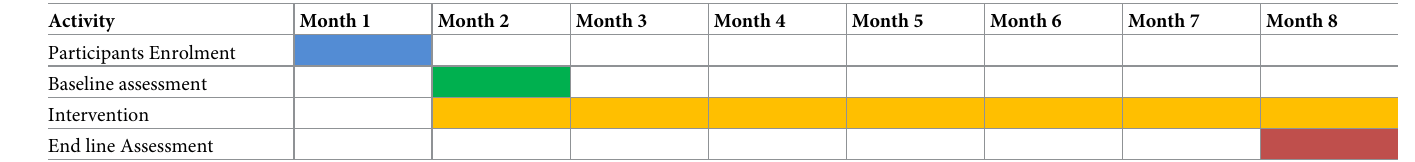
Table 2. Participants’ timeline of enrolment, intervention and